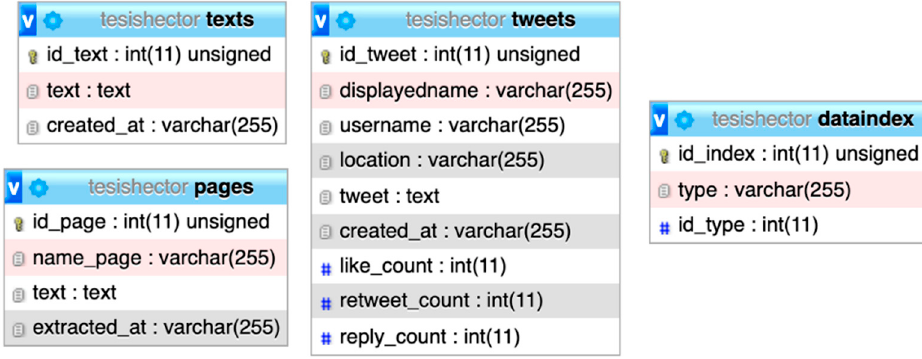
Figure 3. Relational database schema (raw data collection).